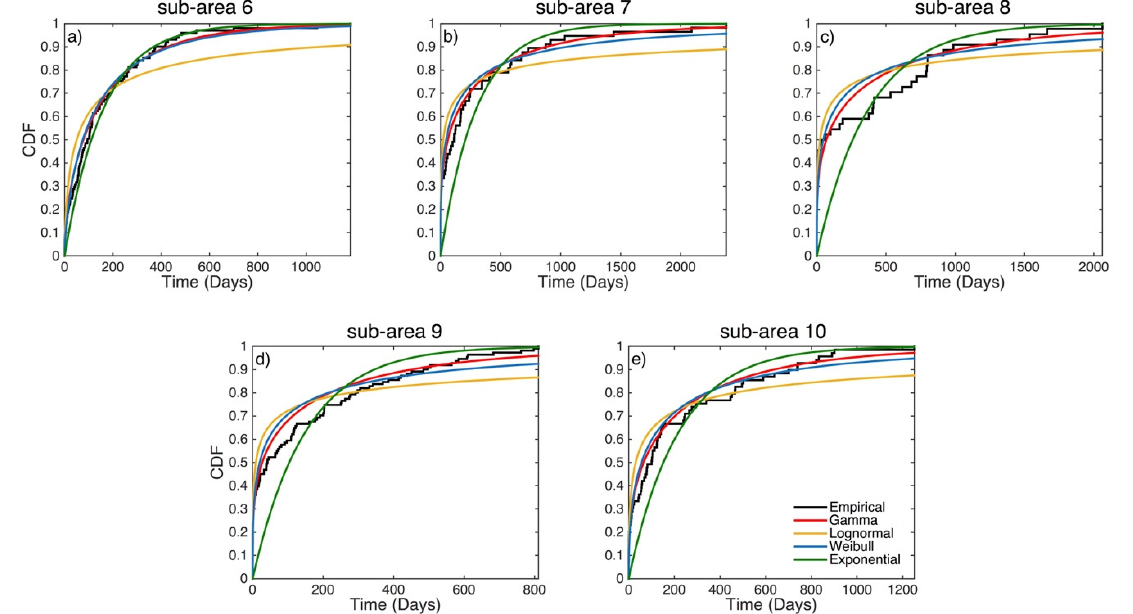
Figure 8. Comparison of empirical cdf (black lines) and the cdfs of Gamma (red lines), Lognormal (yellow lines), Weibull (blue lines) and Exponential (green lines) applied distributions for sub-areas 6 to 10 (subplots a – e ).